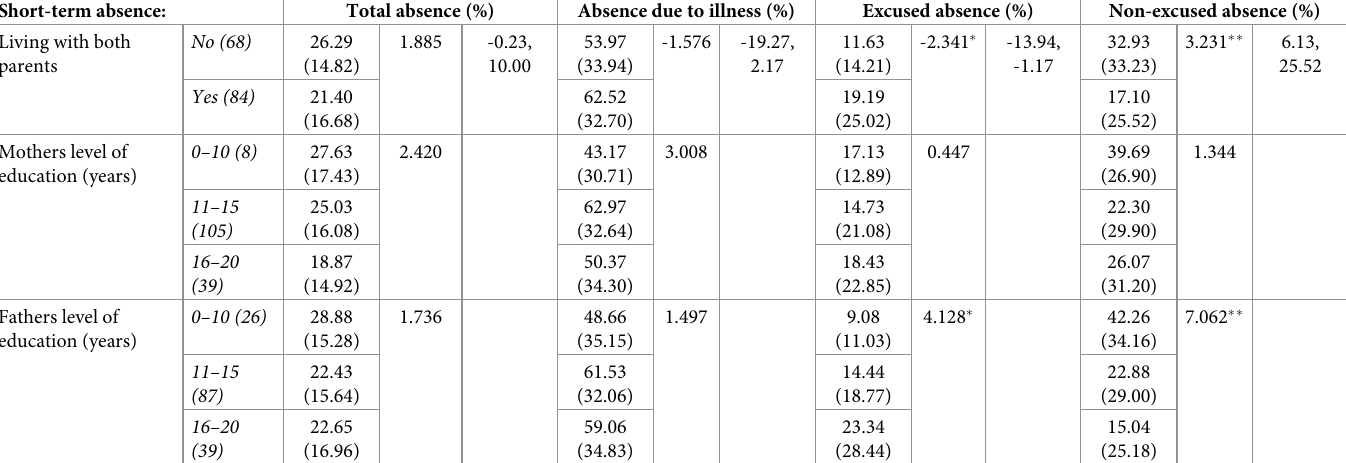
term absence ( M = 29.4%, SD = 19.4) compared to youths without mental health problems ( M = 21.5%, SD = 14.1, t (150) = -2.34, p < . .01). Youths’ whose parents had mental health problems had a significantly higher percentage of short-term absence ( M = 41.7%, SD = 27.7) compared to the other youths ( M = 31.5%, SD = 24.4, t (150) = -2.30, p < .05). There was also a significant difference in the amount of long-term absence between the youths whose parents had mental health problems ( M = 29.8%, SD = 19.2) compared with the youths who did not ( M = 20.5%, SD = 13.3, t (150) = -3.08, p < .01). Youths living with both parents had a signifi- cantly lower percentage of short-term absence categorized as non-excused ( M = 19.0%, SD = 31.4) compared to youths in other living situations ( M = 33.4%, SD = 34.9, t (150) =